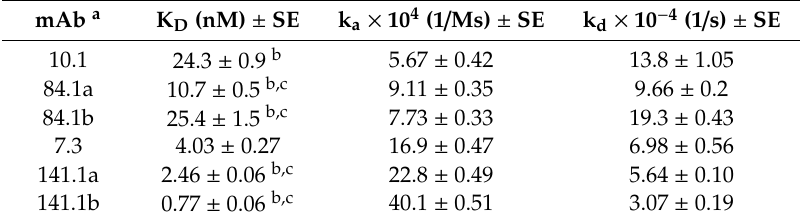
Table 3. A ffi nity of anti-V mAbs to the Y. pestis V-antigen determined by Biacore